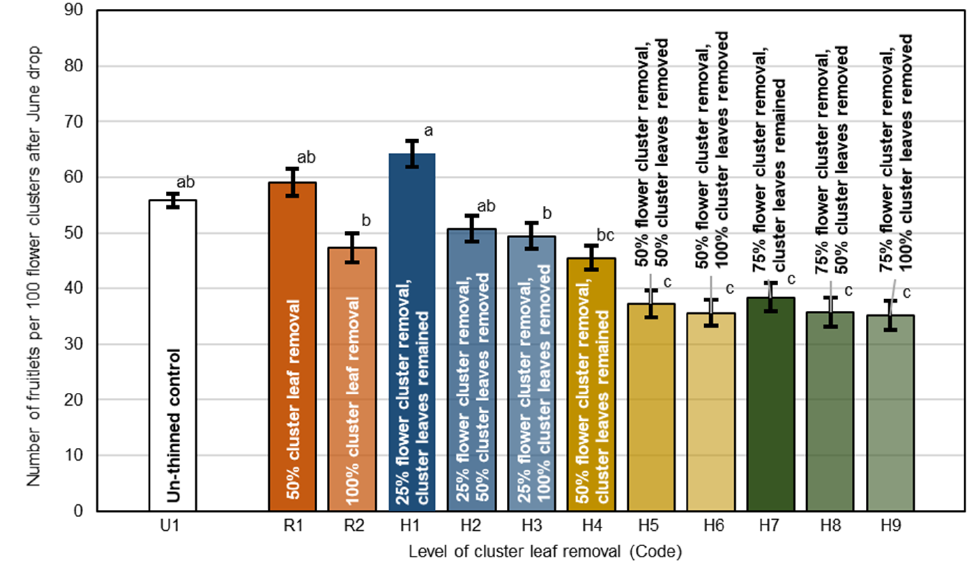
Figure 6. Effect of source-sink modification such as cluster leaf and flower cluster removal on fruit set expressed as number of fruitlets after June drop per 100 flower clusters (color coding and explanations as for Figure 4).